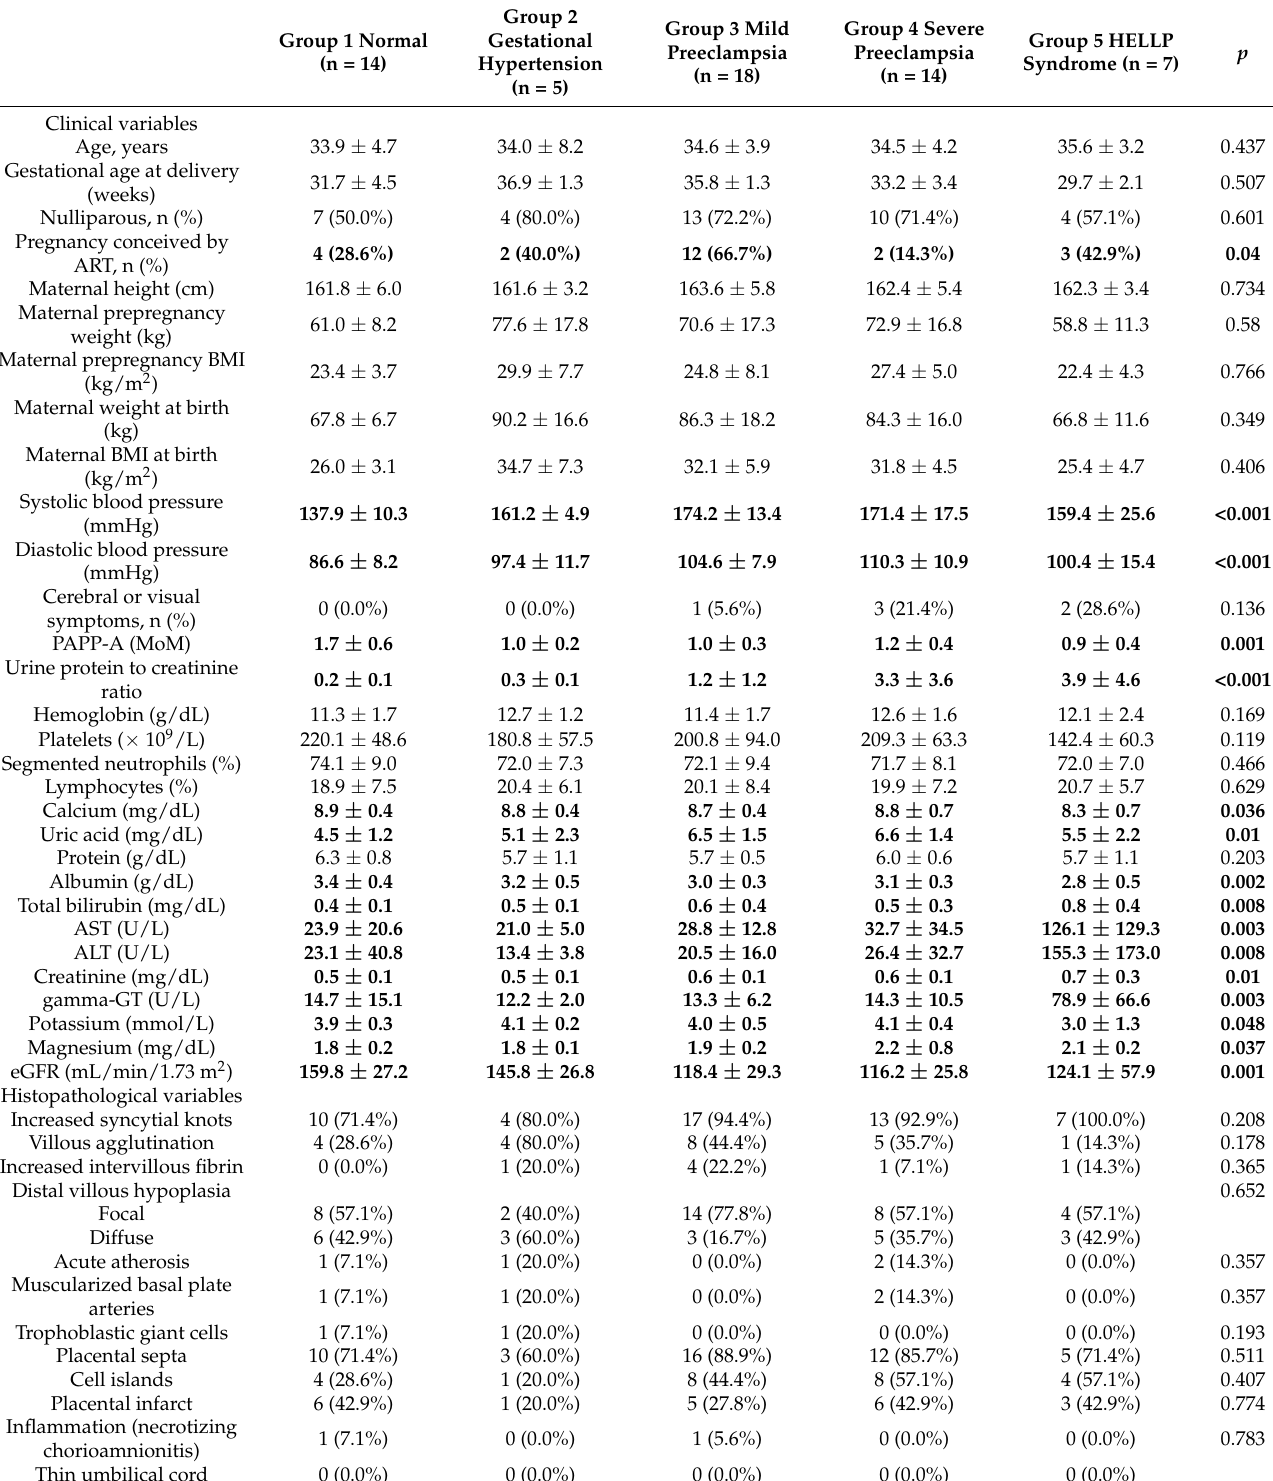
Table 1. Frequencies of clinical and placental